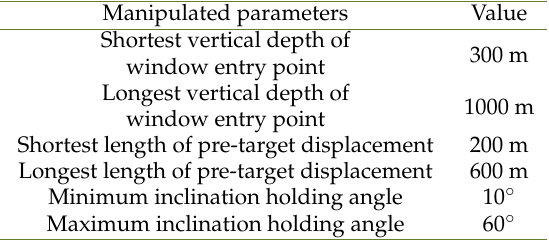
Table 3. Case Well#1 manipulated parameters